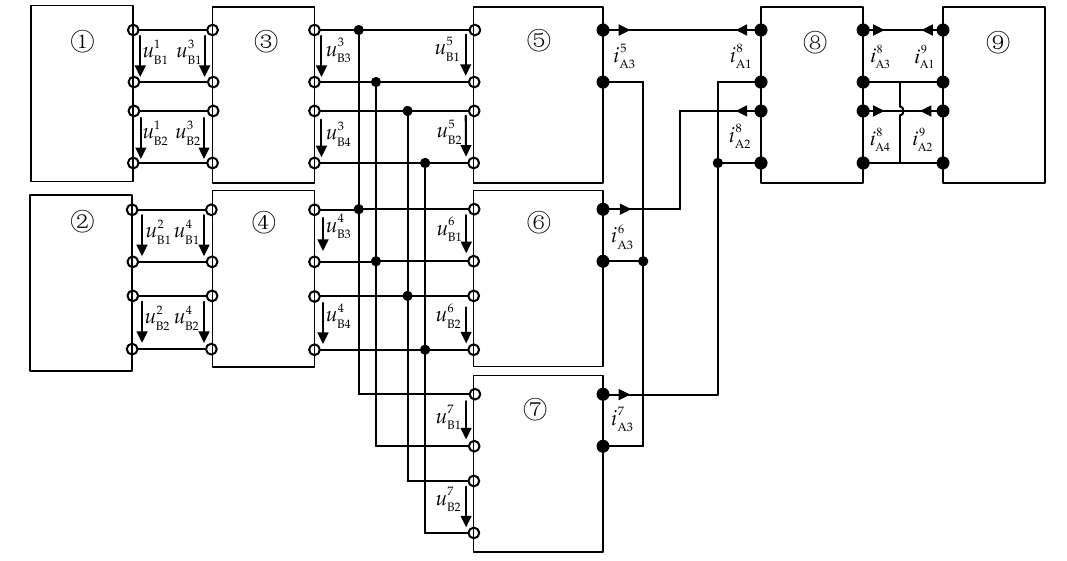
Figure 15. The nine subnetworks connected to solve interface input currents/voltages.